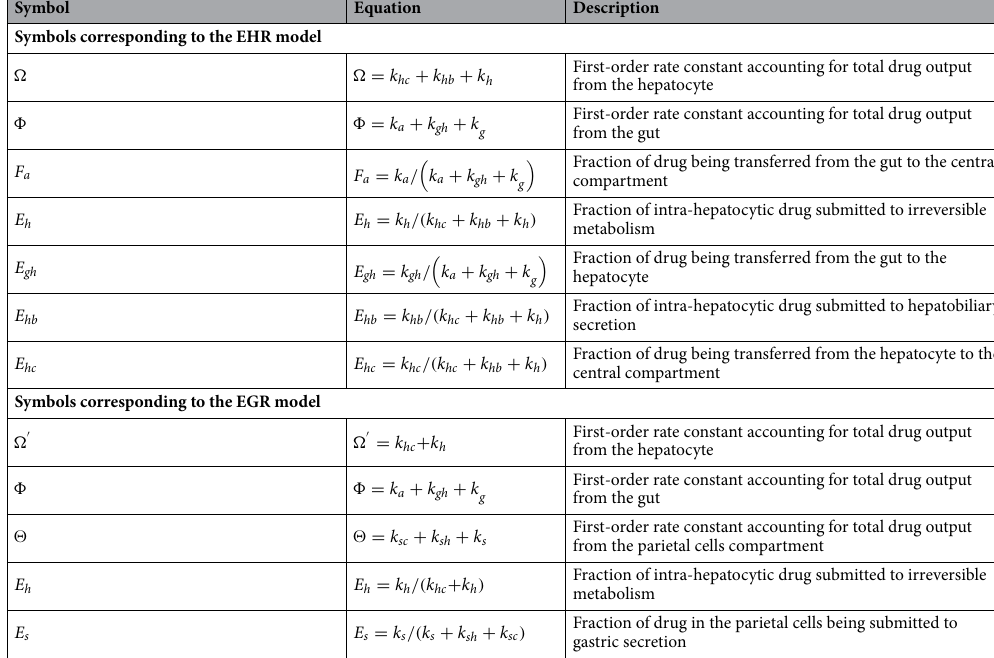
A. Hepatic metabolism as the primary elimination route, with low hepatic extraction ( E h ~30%). Renal and intestinal elimination as secondary routes. Example drugs: amiodarone 2,3 , azithromycin 2,12 , ezetimibe 2,3,12 ,